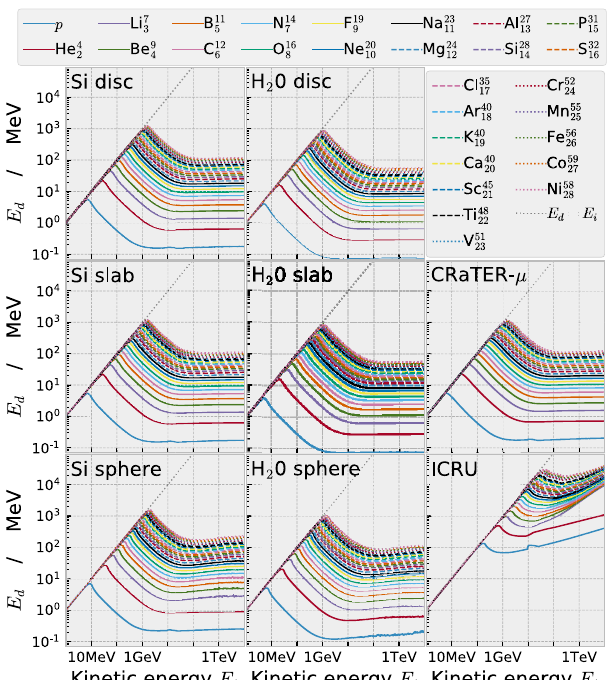
Fig. 1. Detector response to charged particles: the deposited energy E D is shown as a function of kinetic energy E i . To each detector corresponds a single panel. For example the central panel is showing data for the H 2 O slab detector. The Si disc and Si slab detectors mimic typical semiconductor detectors used in space-related dosi- metric experiments. The dotted line with slope 1 corresponds to full absorption. The different GCR nuclei are indicated with different colors and line styles, as shown in the